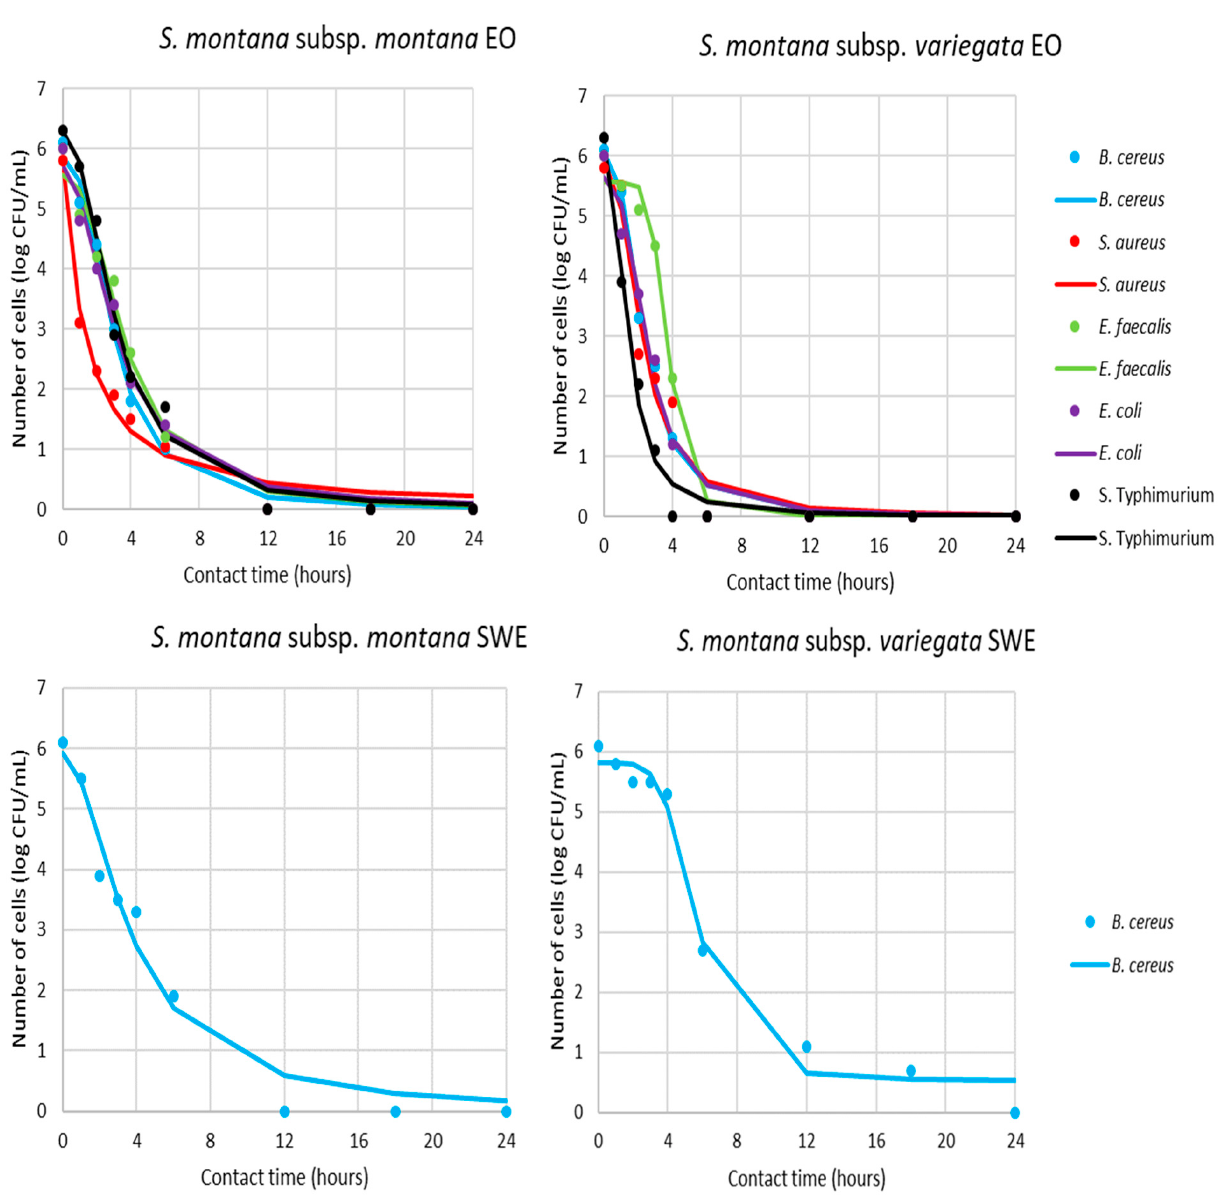
Figure 4. Time–kill kinetics of bacterial growth in presence of MICs of antimicrobials (markers signify the experimental data; lines indicate predictive results).